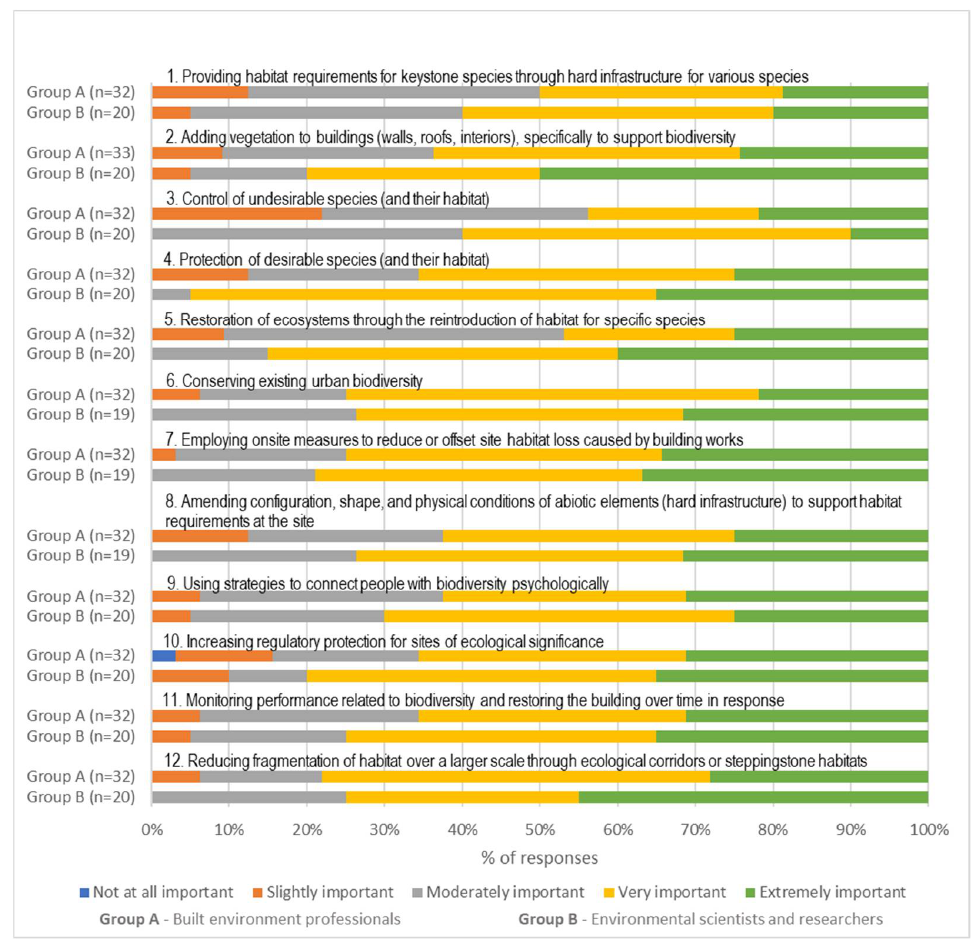
Figure 12. Strategies to increase urban biodiversity or habitat provisioning through building de- sign.